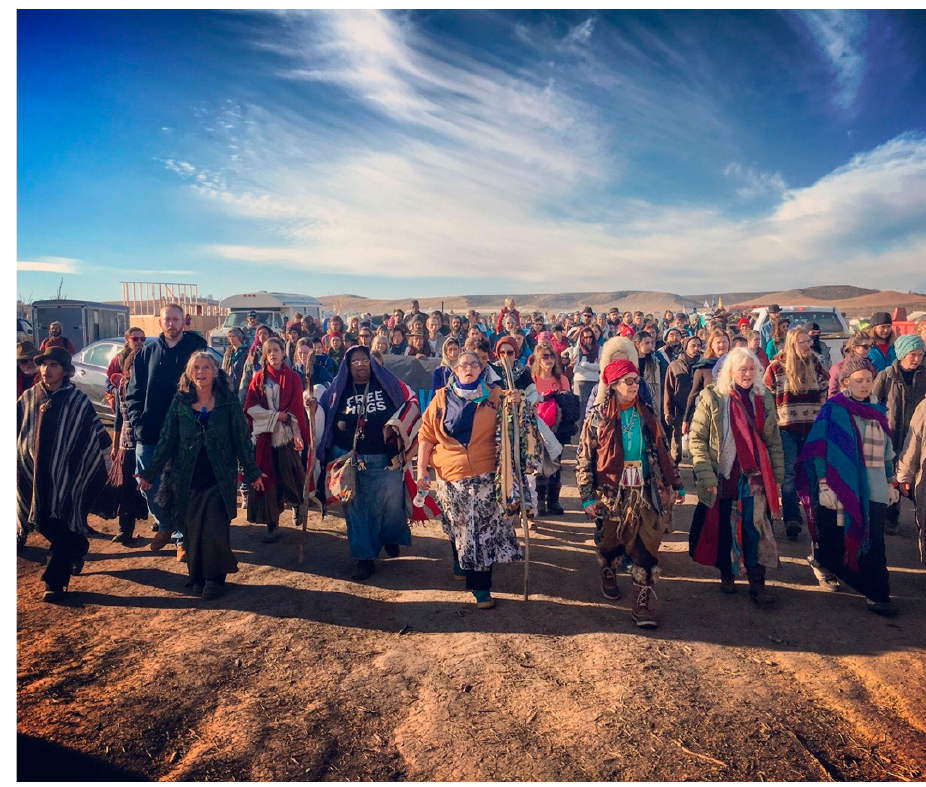
Figure 2. Women of Standing Rock Marching (Lemere 2016).